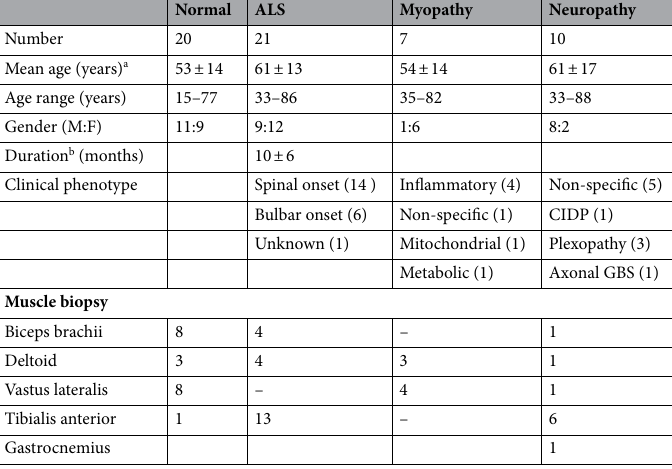
Table 1. Demographic and clinical data of muscle biopsy cohorts. CIDP chronic inflammatory demyelinating polyradiculoneuropathy, GBS Guillain Barre syndrome, SD standard deviation. a Mean age (± SD) at time of sample collection. b Mean duration (± SD) from onset of symptoms to sample collection. Duration was unknown in three patients.